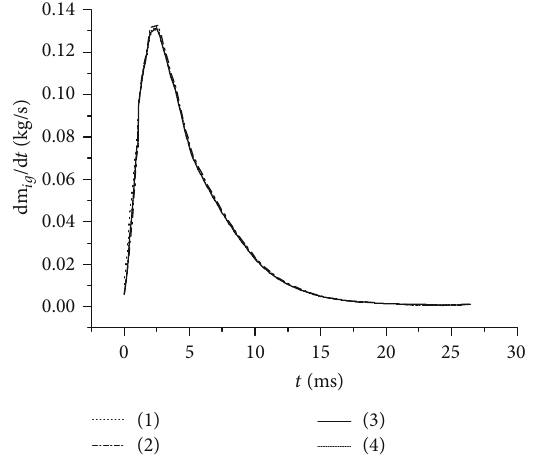
Figure 5: The igniter MFR results computed in di ff erent